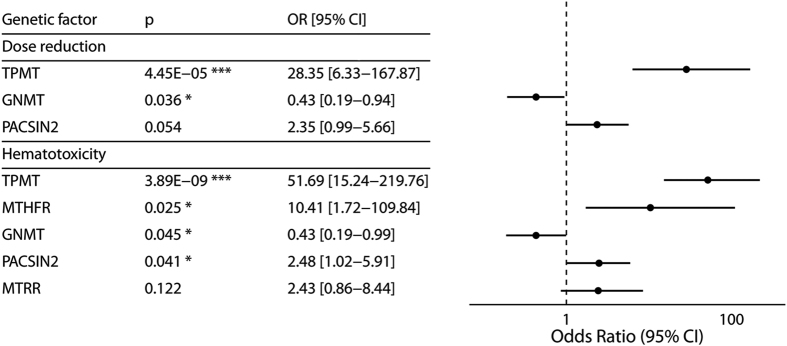
Effects of genotypes in multivariate logistic regression models predicting dose reduction and occurrence of 6-MP related hematotoxicity.Footnotes: Significance codes (p): ***0.001, **0.01, *0.05, “.” 0.1; Abbreviations: OR = odds ratio, CI = confidence interval; Both models were adjusted to treatment protocol, age at diagnosis and gender. Genetic factors: TPMT: *1/*3 vs. *1/*1; GNMT: 1298CC vs 1298CT/TT; PACSIN2: rs2413739 CC/CT vs rs2413739 TT; MTHFR: wild-type (677CC/1298AA) vs genotype combinations with at least one mutation (677CC/1298AC, 677CT/1298AA, 677CC/1298CC, 677TT/1298AA, 677CT/1298AC, 677TT/1298AC); MTRR: 66AA vs 66AG/GG.